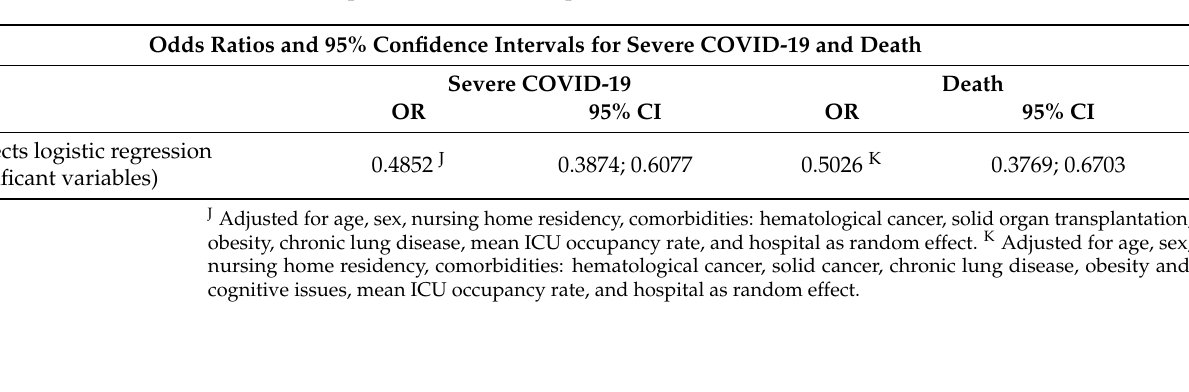
Table A3. Simplified model after stepwise backward